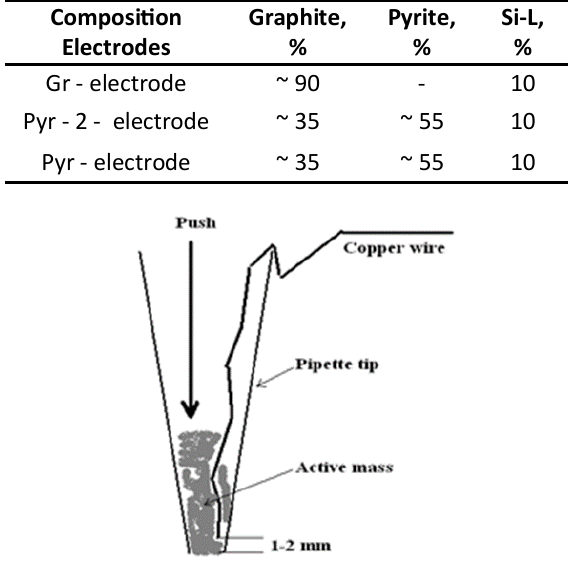
Fig. 1. Scheme of the electrode